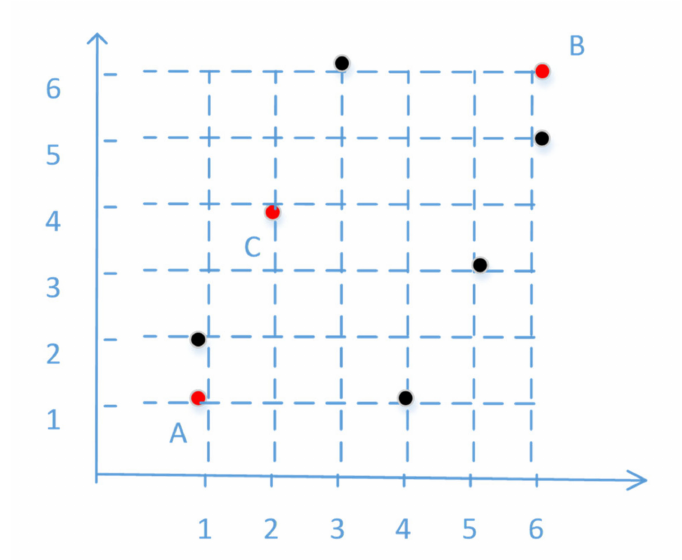
Figure 2. Example of ULS.